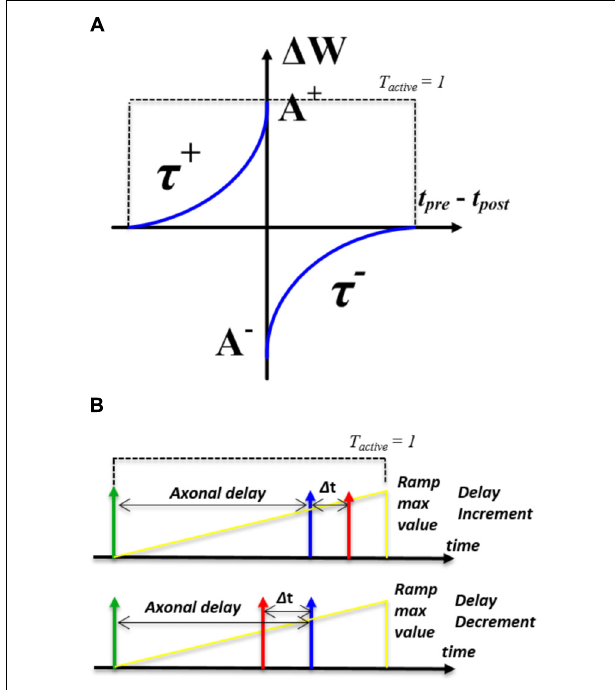
FIGURE 2 | Illustration of learning rules. (A) the STDP modification function; (B) the STDDP learning rules.